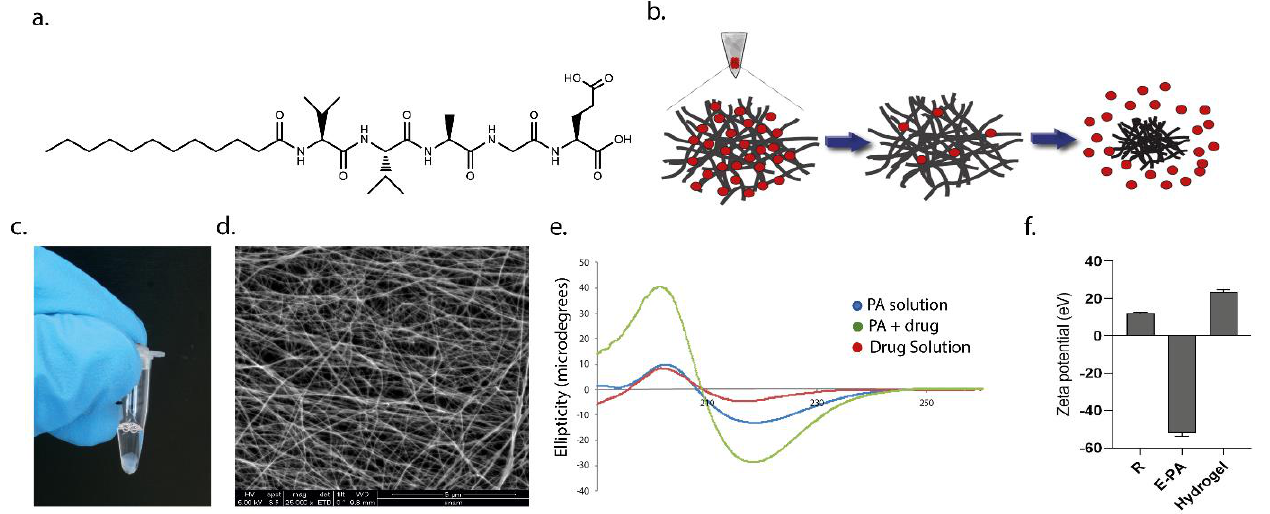
Figure 1. Peptide hydrogel nanofiber delivery system for the anti-VEGF drug. ( a ) Chemical structure of the glutamic acid-bearing peptide amphiphile (E-PA) molecule. ( b ) Schematic representation of anti-VEGF release strategy. ( c ) Self-supportive nanofiber delivery system formed in a tube. ( d ) SEM micrograph of the nanofiber network of E-PA/ranibizumab (1:1 [ w/v ]) (Scale bar = 5 µm). ( e ) Circular dichroism spectra of peptide amphiphile (E-PA) and its self-assembled nanofiber with ranibizumab (E-PA/ranibizumab). ( f ) Zeta potentials of ranibizumab, E-PA, and self-assembled nanofiber (E- PA/ranibizumab).